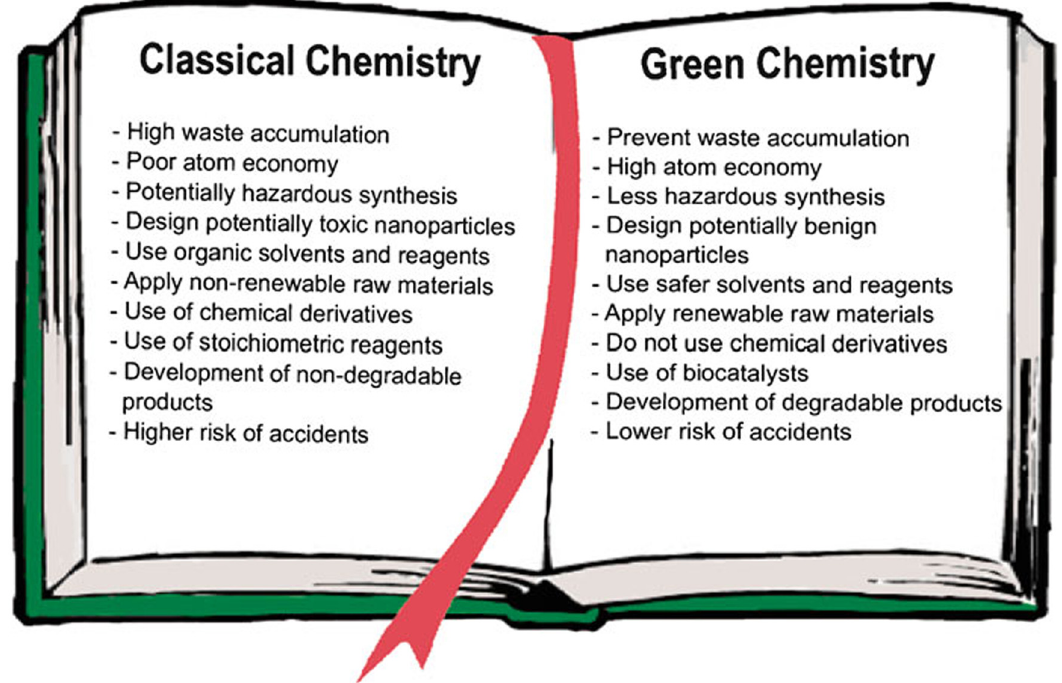
Figure 17: Comparison of the concepts and repercussions of traditional chemistry and green chemistry [ 41 ]